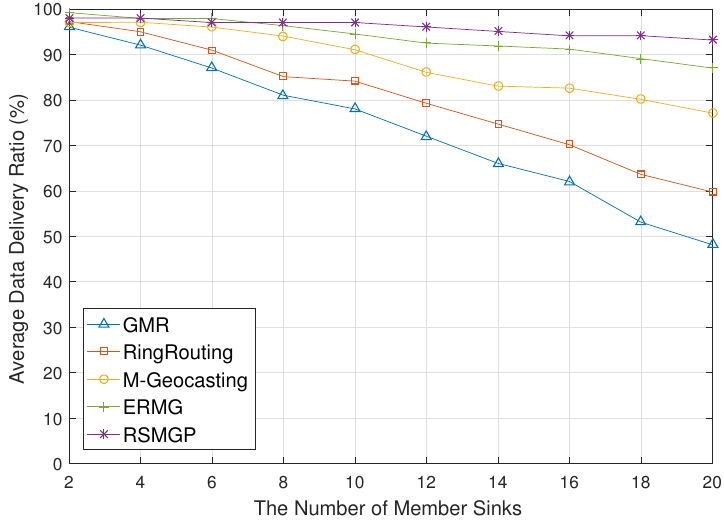
Figure 10. Data delivery ratio impacted by the number of member